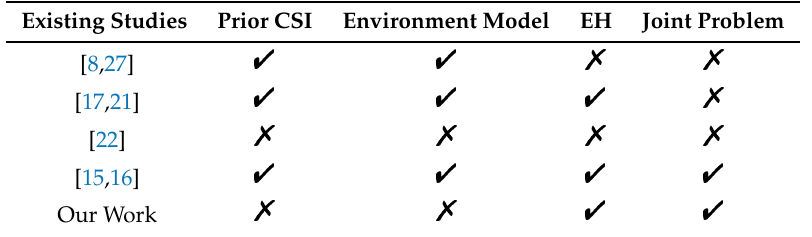
Table 1. Literature